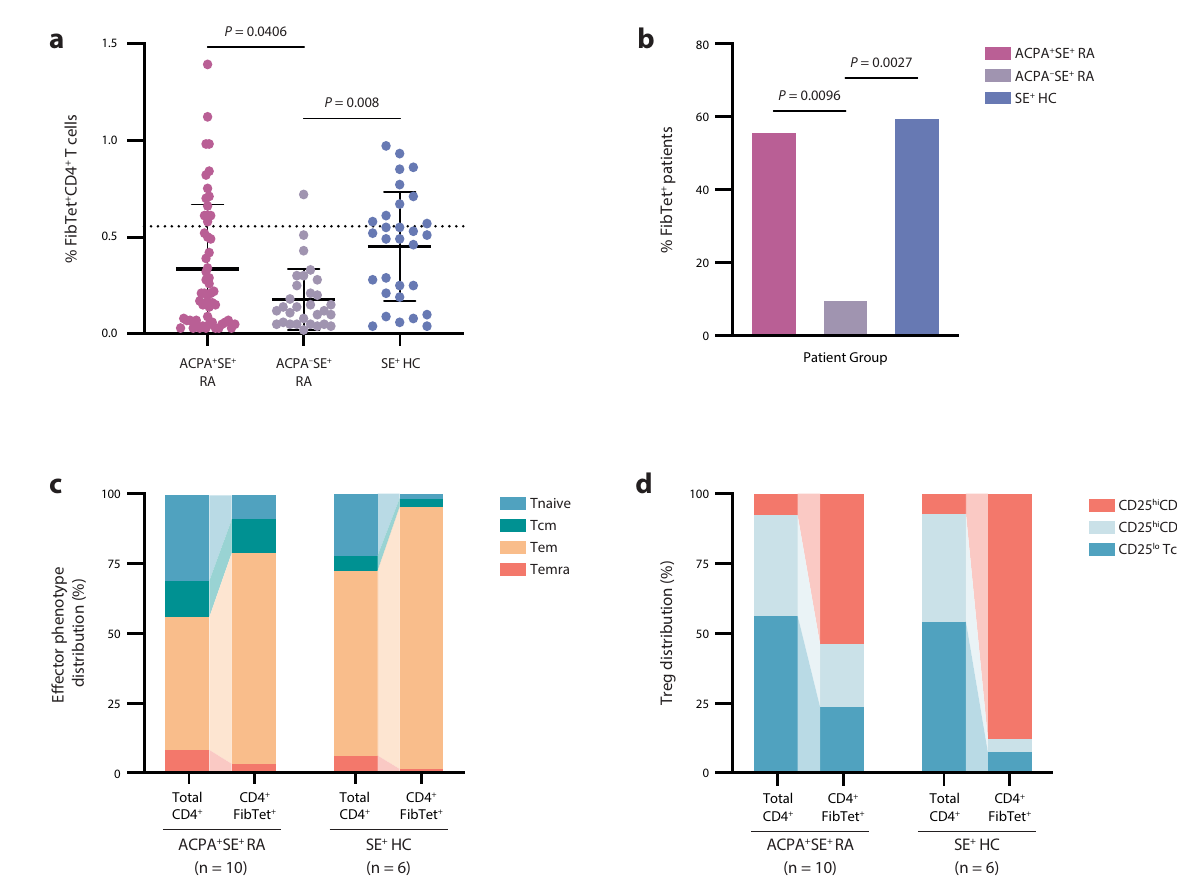
mean±SD, and P values werecalculated by ordinary one-wayANOVA with Tukey ’ s multiple comparisons test. Only signi fi cant P values ( ≤ 0.05) are shown. b The percentage of individuals that bound any FibTet is shown for each group. Two- sided χ 2 tests were used to compare the frequency of T-cell responses between patient groups. Only signi fi cant P values ( ≤ 0.05) are shown. c , d Distribution of effector phenotypes ( c ) and regulatory T cells ( d ) for ACPA + SE + RA patient and SE + healthy control fi brinogen tetramer – positive T cells. Phenotypes denoted in